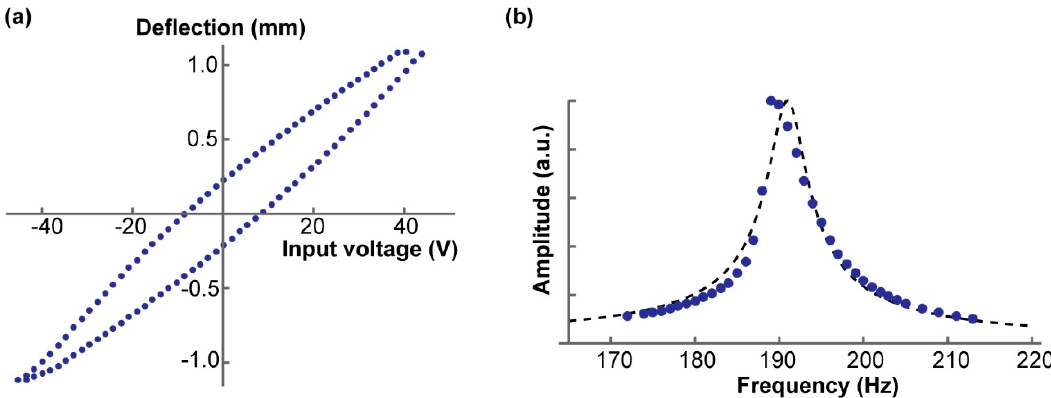
Figure 2. Characteristics of the piezoelectric bimorph actuator. ( a ) The applied voltage to the piezoplate versus the piezoplate deflection. Typical non-linear characteristic of piezoelectric material was quantified. ( b ) The frequency response of the piezo actuator given an initial input frequency and measuring the corresponding output amplitude. The dotted line is the curve fit to the theoretical frequency response of a damped harmonic oscillator. This graph allowed for the calculation of resonant frequency ( f pz ), e ff ective mass ( m pz ), Q factor ( Q pz ), and damping coe ffi cient ( c pz